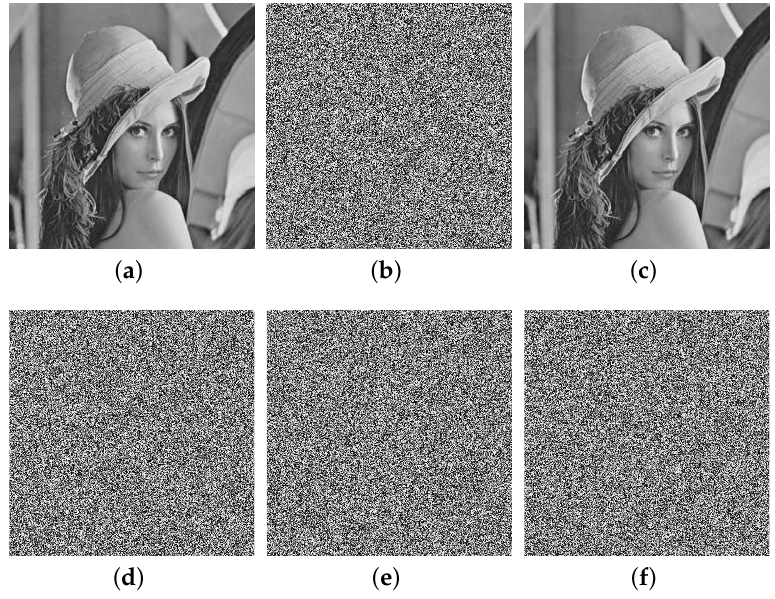
Figure 13. Testing results for key sensitivity. ( a ) Lena, ( b ) the encrypted image of Lena, ( c ) the decrypted image of Lena, ( d – f ) three examples of the decryption result when a random bit of the hash is changed